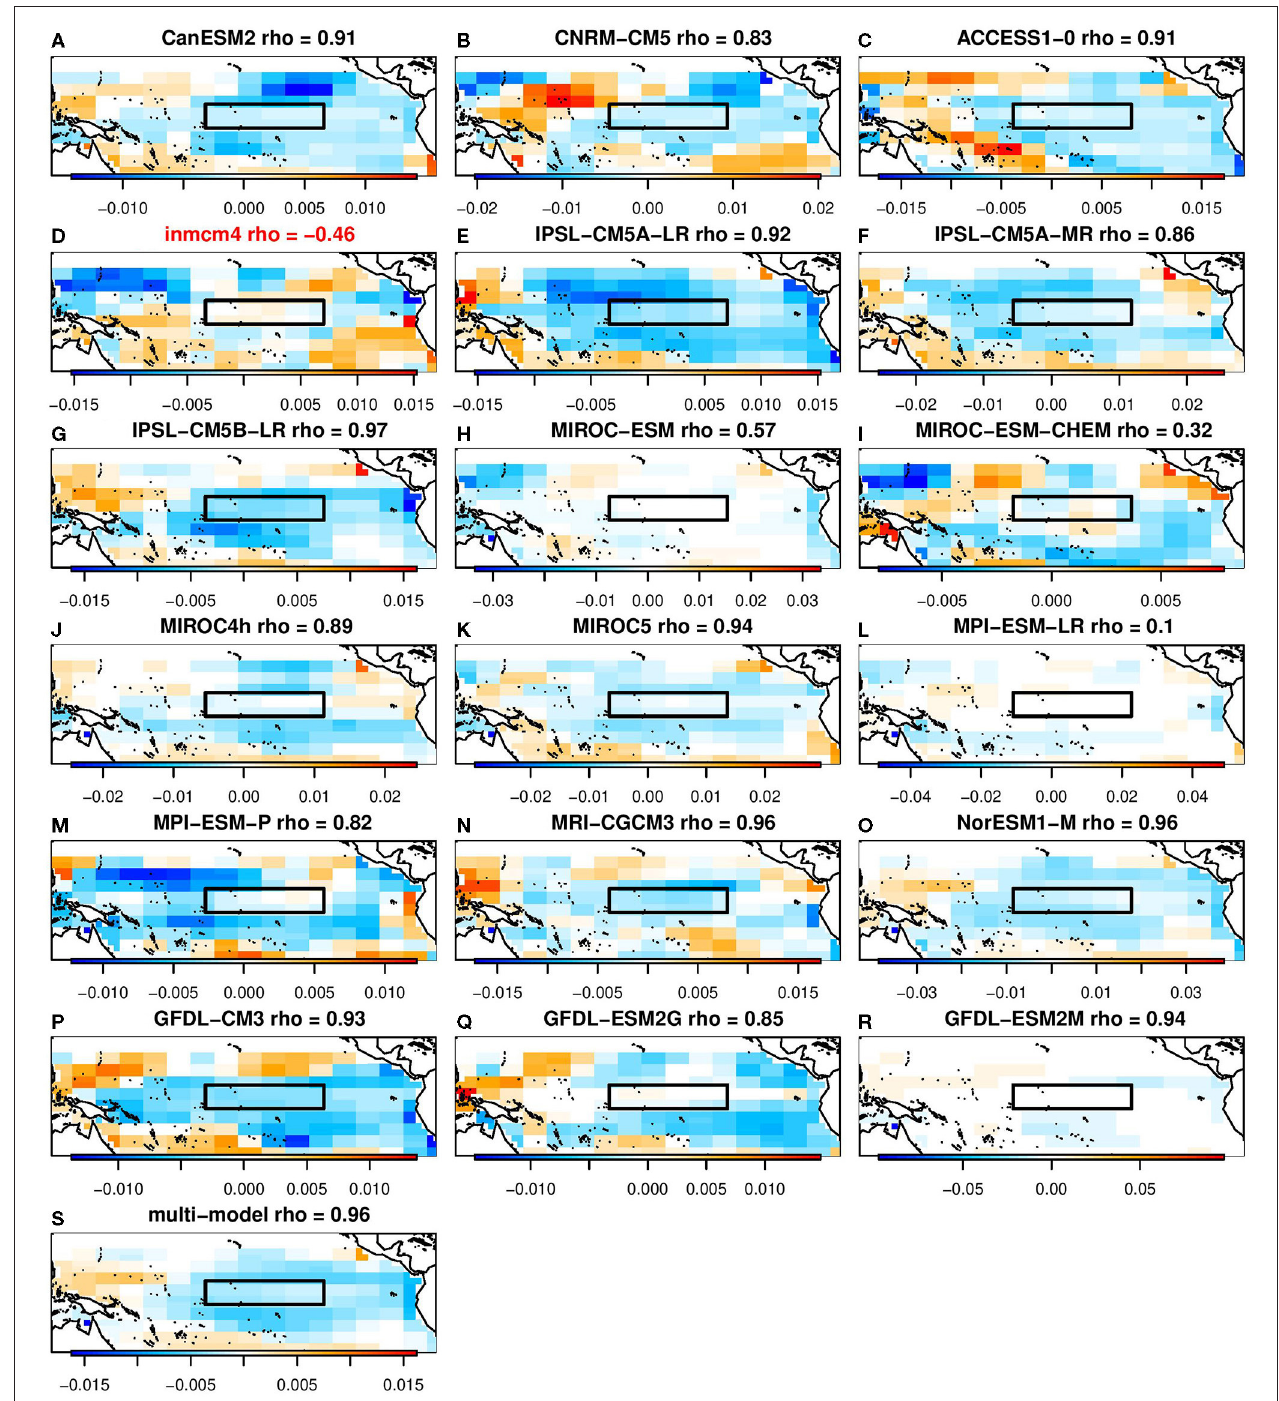
FIGURE 6 | The β coefficients selected by ridge regression for predicting week 3–4 ENSO-forced temperature pattern using grid points in the Tropical Pacific. The black boxes indicates the Nino3.4 index. Red model names indicate the models that individually had a minimum NMSE greater than 1. (A) CanESM2 rho= 0.91. (B) CNRM-CM5 rho = 0.83. (C) ACCESS1-0 rho = 0.91. (D) inmcm4 rho = − 0.46. (E) IPSL-CM5A-LR rho = 0.92. (F) IPSL-CM5A-MR rho = 0.86. (G) IPSL-CM5B-LR rho =0.97. (H) MIROC-ESM rho = 0.57. (I) MIROC-ESM-CHEM rho = 0.32. (J) MIROC4h rho = 0.89. (K) MIROC5 rho = 0.94. (L) MPI-ESM-LR rho = 0.1. (M) MPI-ESM-P rho = 0.82. (N) MRI-CGCM3 rho = 0.96. (O) NorESM1-M rho = 0.96. (P) GFDL-CM3 rho = 0.93. (Q) GFDL-ESM2G rho = 0.85. (R) GFDL-ESM2M rho = 0.94. (S) Multi-model rho = 0.96.